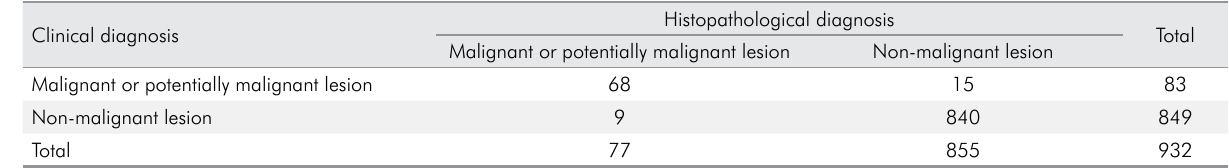
Table 4. Distribution of cases after grouping PMD and malignant lesions in one category for assessment of accuracy, sensitivity and specificity.